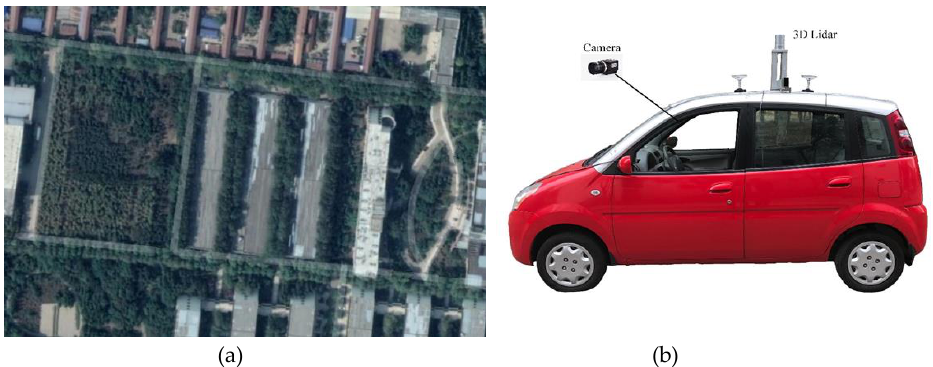
Figure 1. Experiment environment and platform of automatic driving. ( a ) is the actual road scene of the experiment. ( b ) is our experimental platform for algorithm verification.